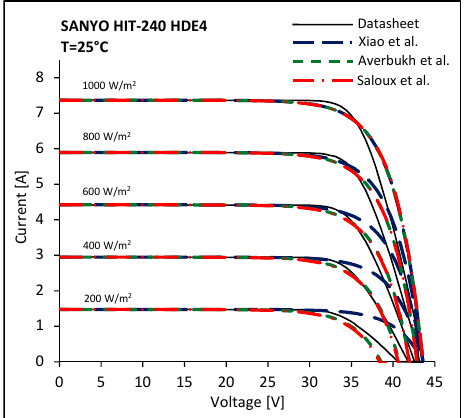
Figure 9. Comparison between the issued I-V characteristics of the Sanyo HIT-240 HDE4 at T = 25 °C and the characteristics calculated by means of the Xiao et al., the Averbukh et al. and the Saloux et al. models.